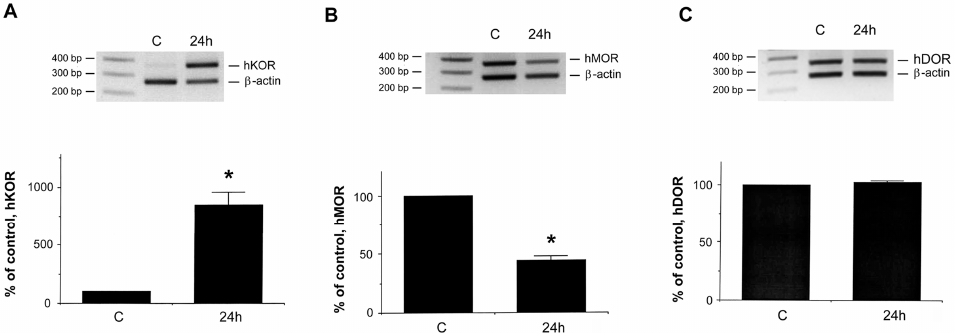
Figure 1. Effect of desferrioxamine (DFO) on opioid receptor gene expression in NMB cells. Cells were treated without (control; C) or with 300 µ M DFO for 24 h. Dead cells were removed. The surviving/attached cells were harvested. RNAs from cells treated without (C) or with DFO for 24 h were extracted. Semi-quantitative RT-PCR was carried out using a pair of human KOR (( A )